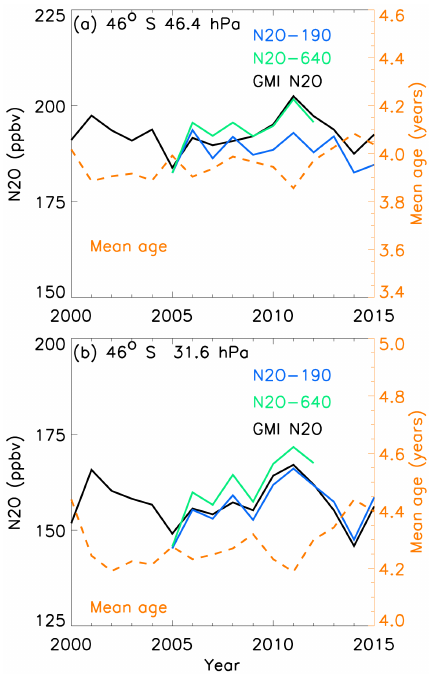
Figure 13. (a) The 46 ◦ S annual zonal mean N 2 O in the GMI CTM (black) follows MLS N 2 O-640 (green) but not N 2 O-190 (blue) at 46.4hPa. The simulated N 2 O is anticorrelated with the mean age and with MLS N 2 O-640. (b) The GMI CTM N 2 O follows both MLS products at 31.6hPa and is anticorrelated with mean age.